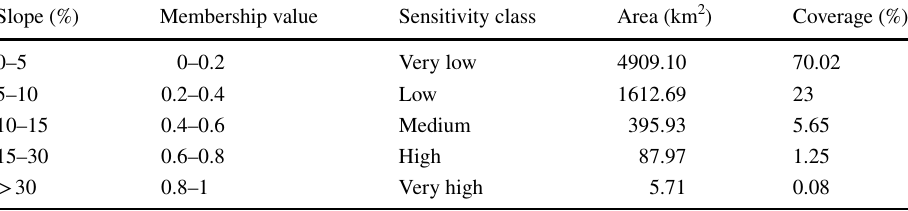
value, distribution and sensitivity